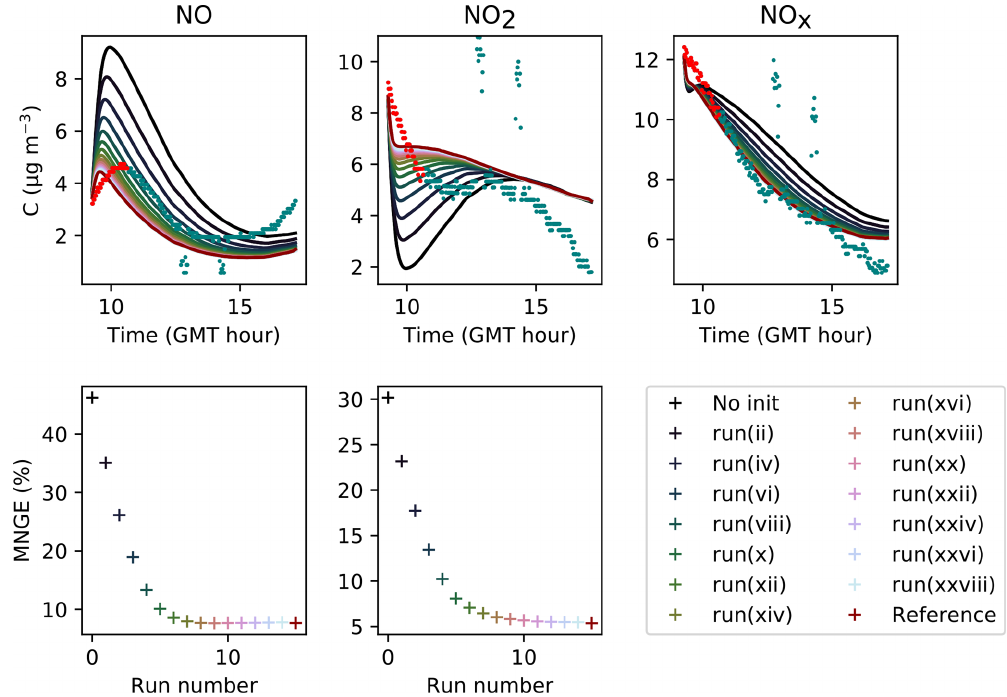
Figure B3. Concentration initialization for Experiment 3: for this experiment, proper initial concentrations are considered to be achieved when the MNGEs with respect to NO and NO 2 have converged to stable